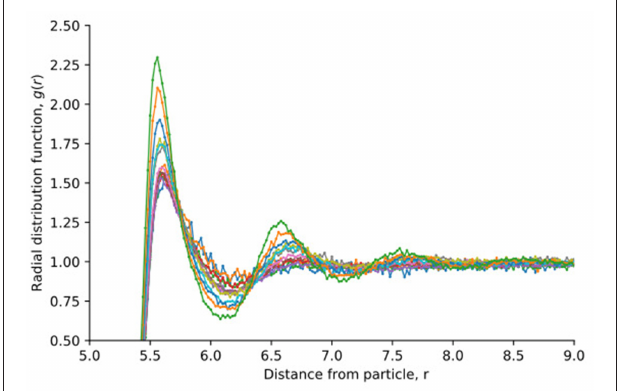
FIGURE 3 | The radial distribution function of fluid particles around a grain, as shown in Figure 4 . Results are shown for densities that vary between ρ ∗ 0.1 and ρ ∗ = =